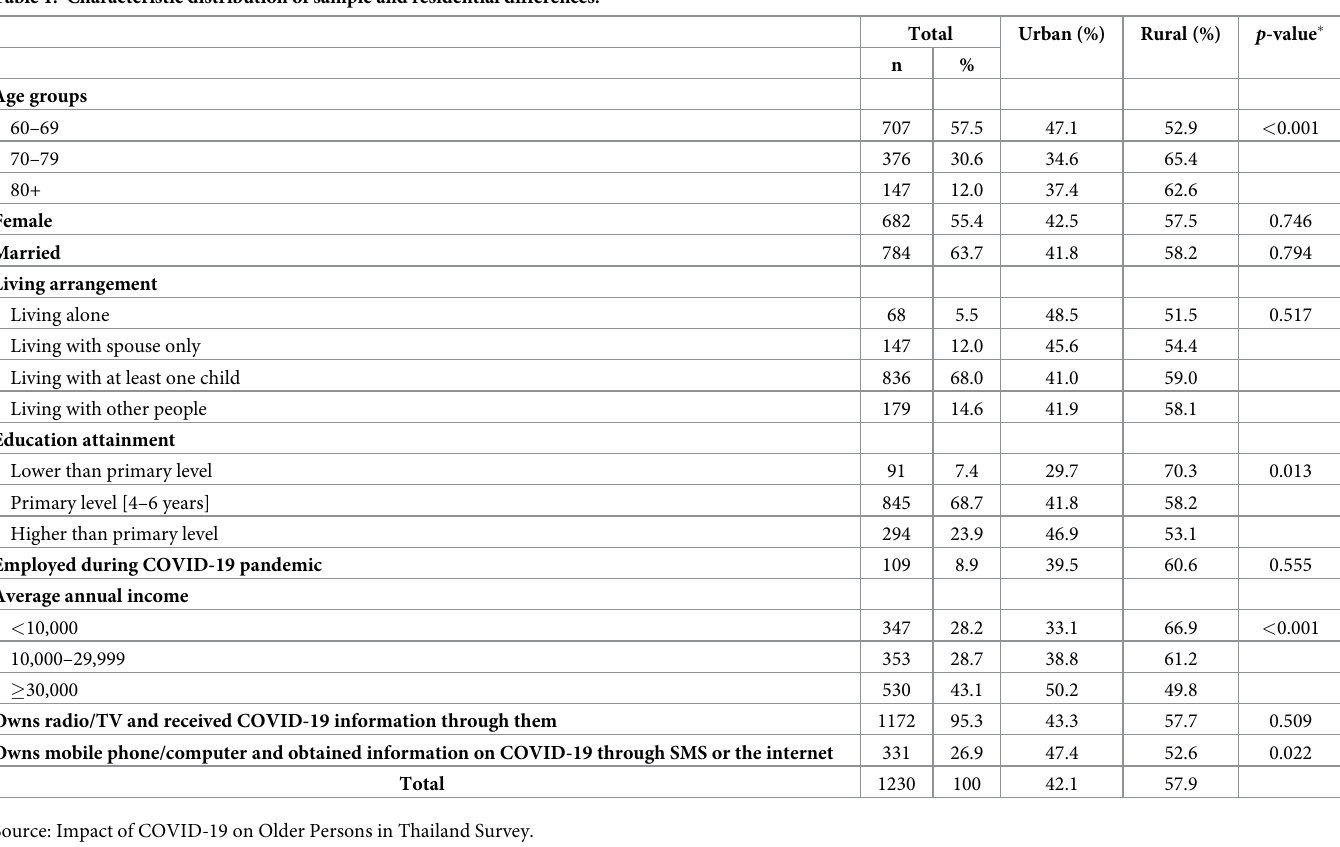
Table 1. Characteristic distribution of sample and residential differences.